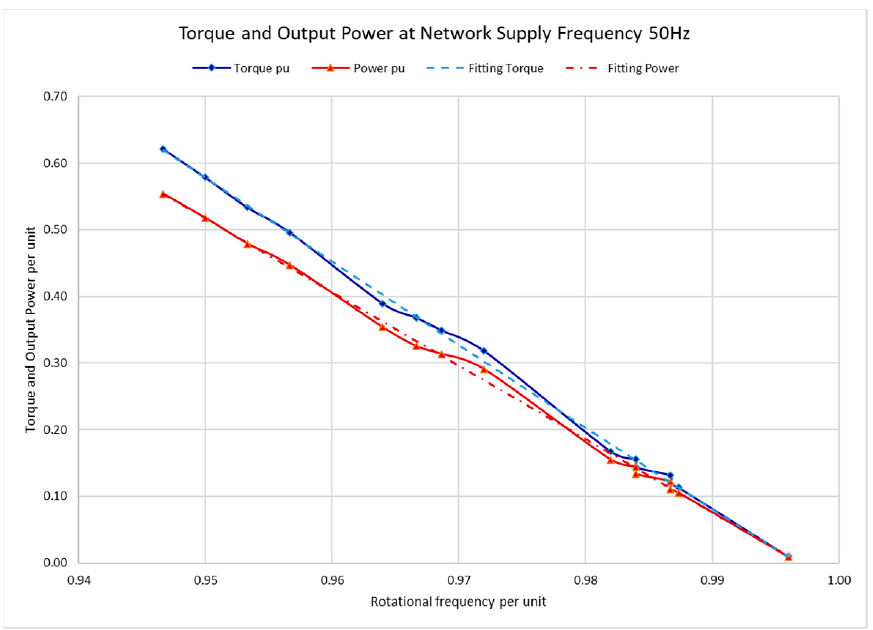
Figure 12. Torque and mechanical power vs. rotational frequency at input frequency 50 Hz (1.0 per unit).